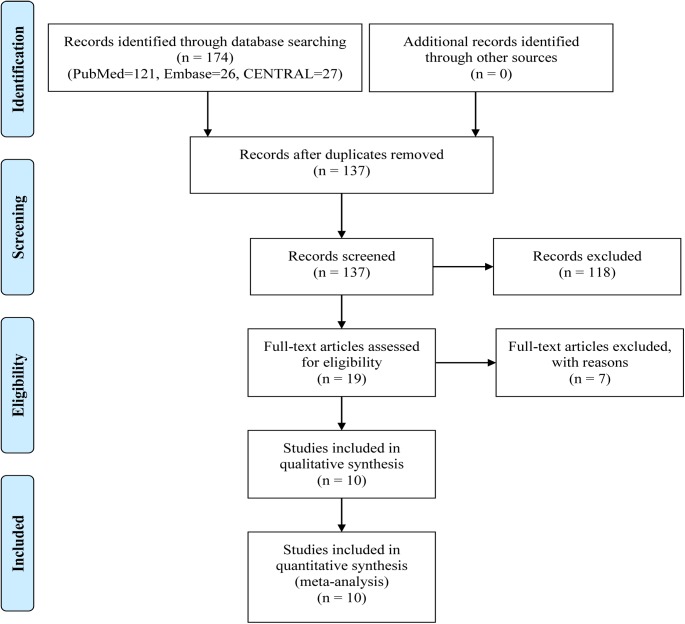
Study selection flowchart.